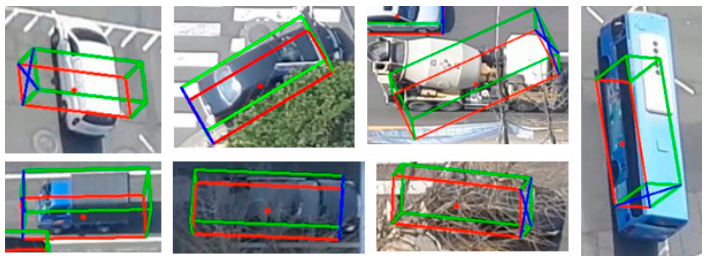
Figure 11. Examples of inaccurate vehicle 3D box estimates based on DCNN models.